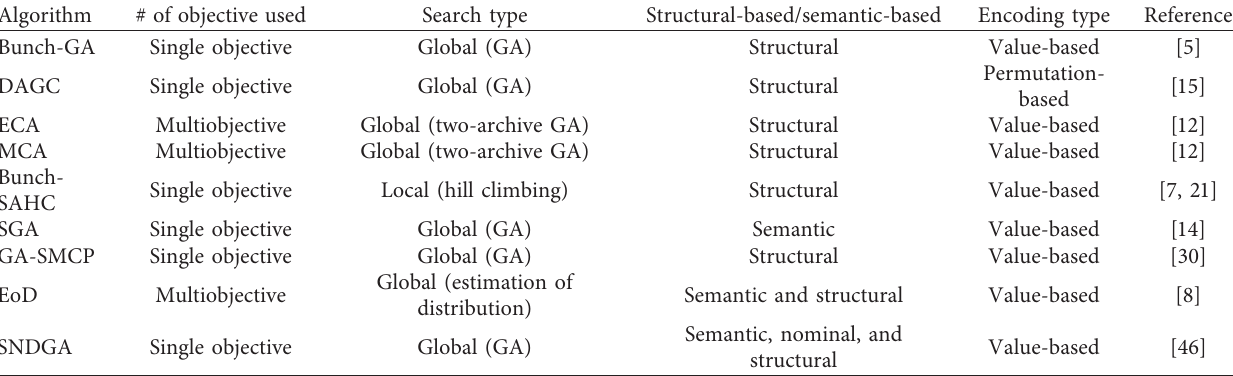
Table 5: Features of selected algorithms search-based algorithms for comparison with the proposed algorithm. Algorithm # of objective